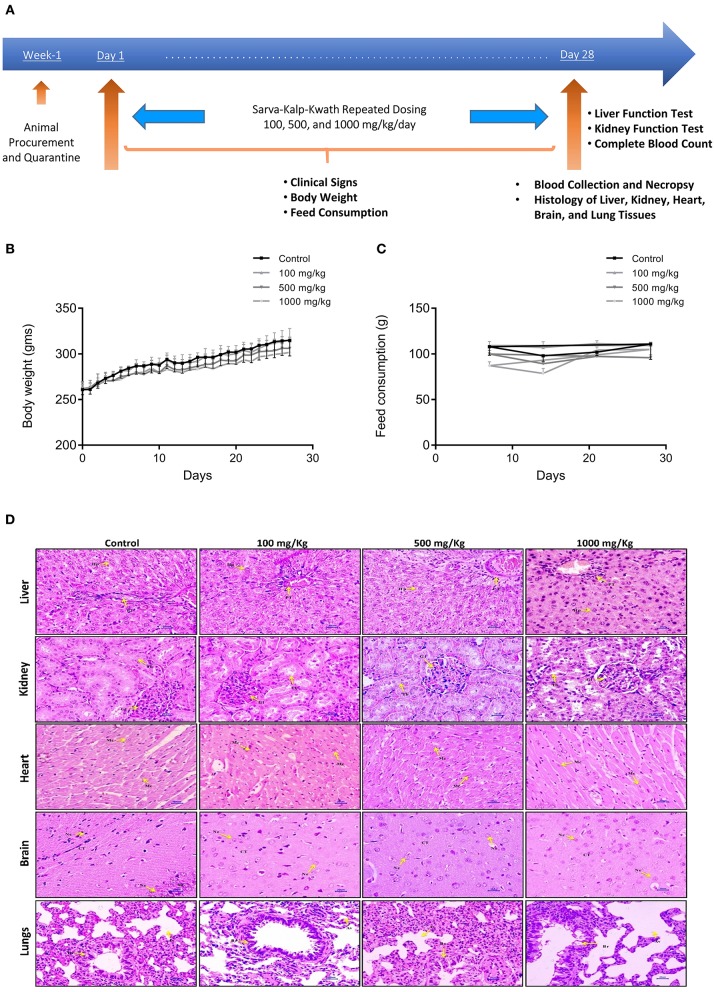
In-vivo Safety Analysis of Divya Sarva-Kalp-Kwath (SKK): (A) Male Wistar rats were randomized and divided into four treatment groups (n = 5): Group 1: Normal control (NC) animals were administered with distilled water only; Group 2: SKK doses of 100 mg/kg; Group 3: SKK dose of 500 mg/kg; and Group 4: SKK dose of 1,000 mg/kg. Water extract of SKK was dissolved in distilled water and administered daily by gavage for 28 days. The animals were observed for physiological, histopathological, and biochemical changes. (B) Body weight change in the SKK exposed animals was measured daily and no changes were detected throughout the study period. (C) Feed consumption of the SKK treated animals was determined daily and averaged per week. The animals did not show any change in their feed consumption. Histopathological analysis of the (D) Liver, kidney, heart, brain, and lung tissue samples obtained from the Wistar rats, did not show any pathological lesions following exposure- Control, SKK 100 mg/kg, SKK 500 mg/ml, and SKK 1,000 mg/kg treatment. Results are expressed as a Mean ± Standard Error of Means. One-way analysis of variance (ANOVA) followed by Dunnett's multiple comparison t-test was used to calculate the statistical difference. No statistical significance was detected.